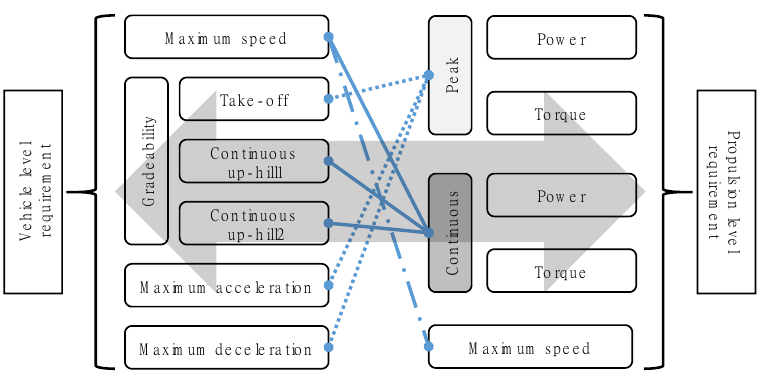
Figure 2. Assignment of vehicle performance requirements to propulsion system requirements. The maximum speed signifies the maximum continuous driving speed of the target vehicle on a flat road (gradient 0%) corresponding to the continuous output of its power system. As an attribute of a vehicle that corresponds to the continuous output of its power system, the performance of that vehicle continuously driving along a gradient road (gradeability) could be taken into account. In addition, the performance in terms of the maximum acceleration and deceleration, along with the maximum gradeability (gradient), correspond to the instantaneous output of the power